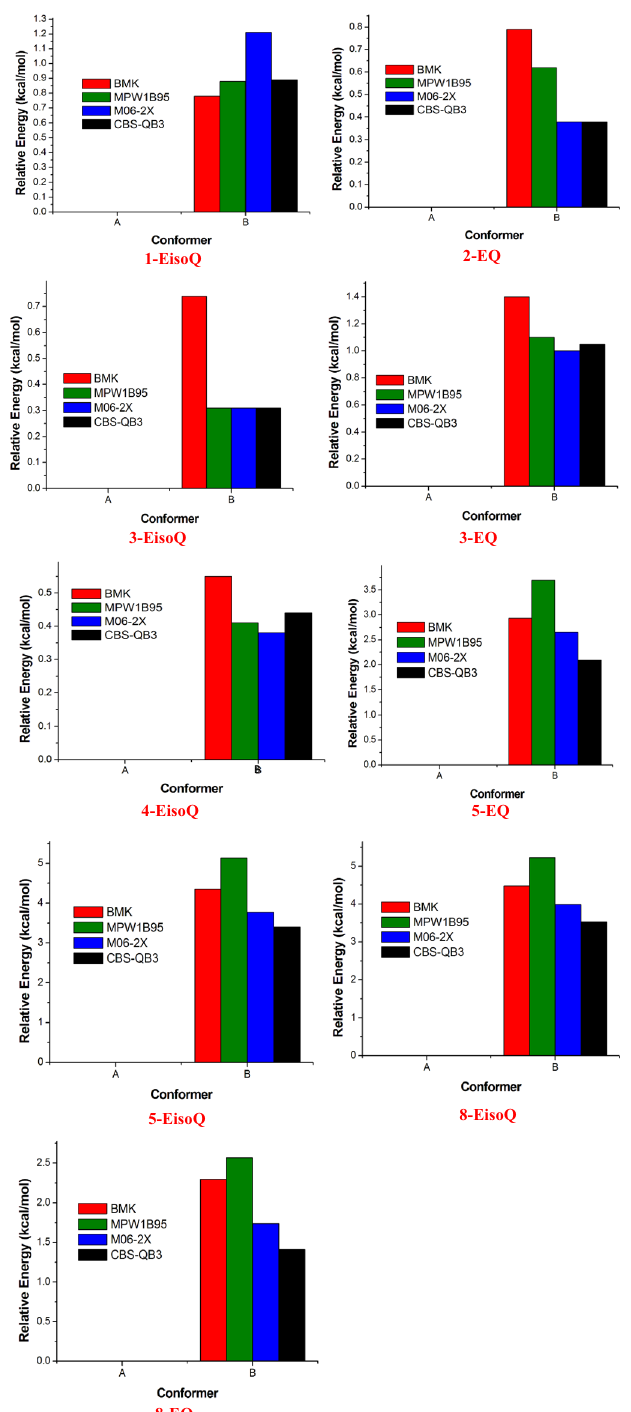
Figure 2. Relative stabilities of different conformers (kcal mol −1 , energies calculated relative to conformer A) at BMK, MPW1B95, M06-2X, and CBS-QB3